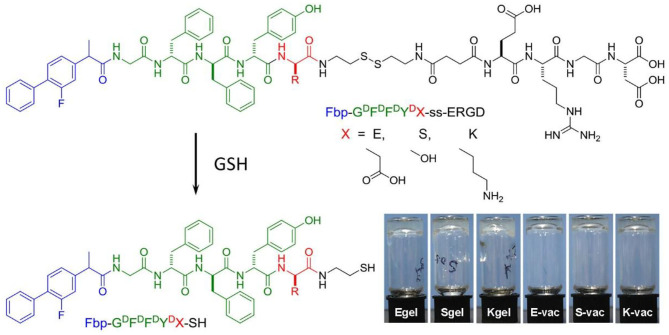
Chemical structure of precursors Fbp-GDFDFDYD(X)-ss-ERGD and hydrogelators Fbp-GDFDFDYD(X)-SH, and the optical images of E-gel, S-gel, K-gel, E-vac, S-vac, and K-vac.